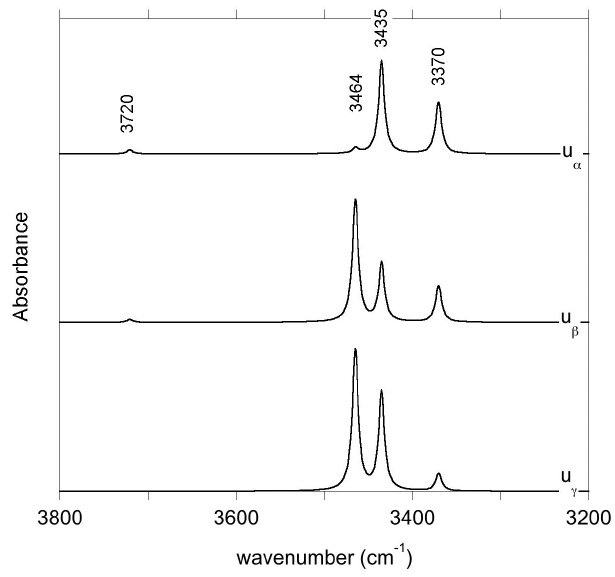
Figure A1. Theoretical infrared spectrum of the (4H) ×